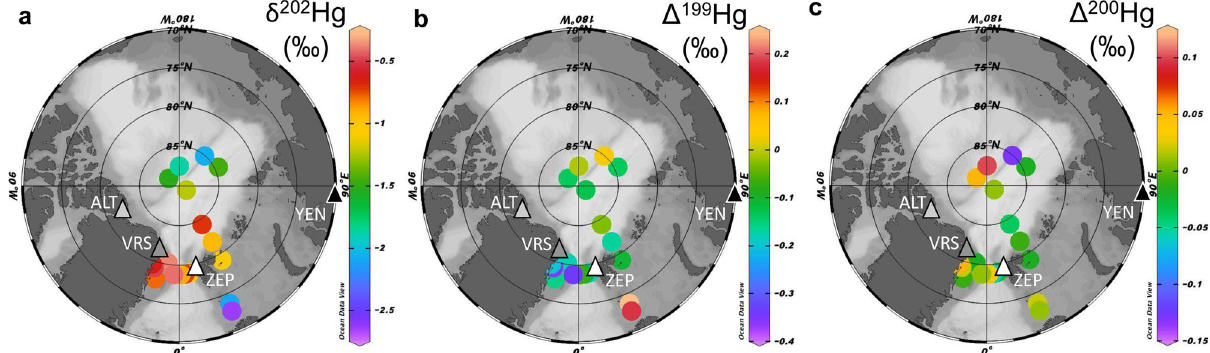
Fig. 1| ArcticsamplinglocationsandmarineHg isotopevariability. Locationof the three atmospheric research stations Alert (83°N, ALT), Villum (82°N, VRS), and Zeppelin (79°N, ZEP), and the city of Igarka, where the Yenisei River (YEN) was sampled(trianglesymbols).AlsoshownarethesurfaceArcticOcean( a )particulate Hg δ 202 Hg, ( b ) particulate Hg Δ 199 Hgand (c ) particulate Hg Δ 200 Hgsignatures (pHg,